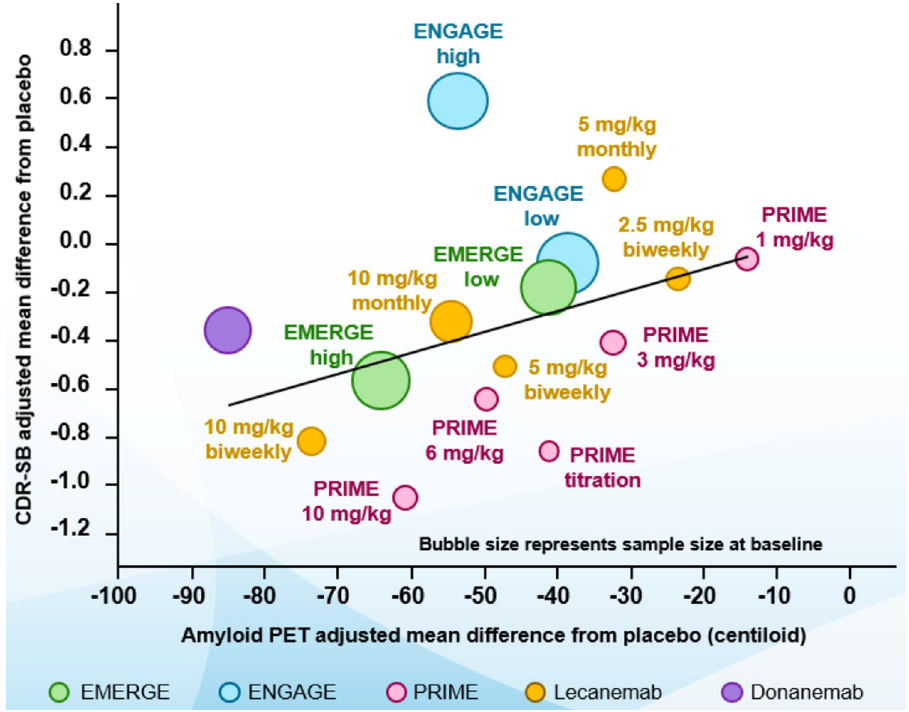
Fig 3. Relationship of plaque lowering and less cognitive decline across anti-A β antibody trials. Graphical relationship between amyloid-lowering effect (abscissa) of various anti-A β antibodies (“compounds”) in individual completed therapeutic trials and their effects on clinical outcome on the CDR-SB test (ordinate). The trend line moving toward the lower left corner across these trials signifies the relationship. (Obtained from reference [74]). A β , amyloid β -protein; CDR-SB, Clinical Dementia Rating-Sum of Boxes; PET, positron emission tomography.